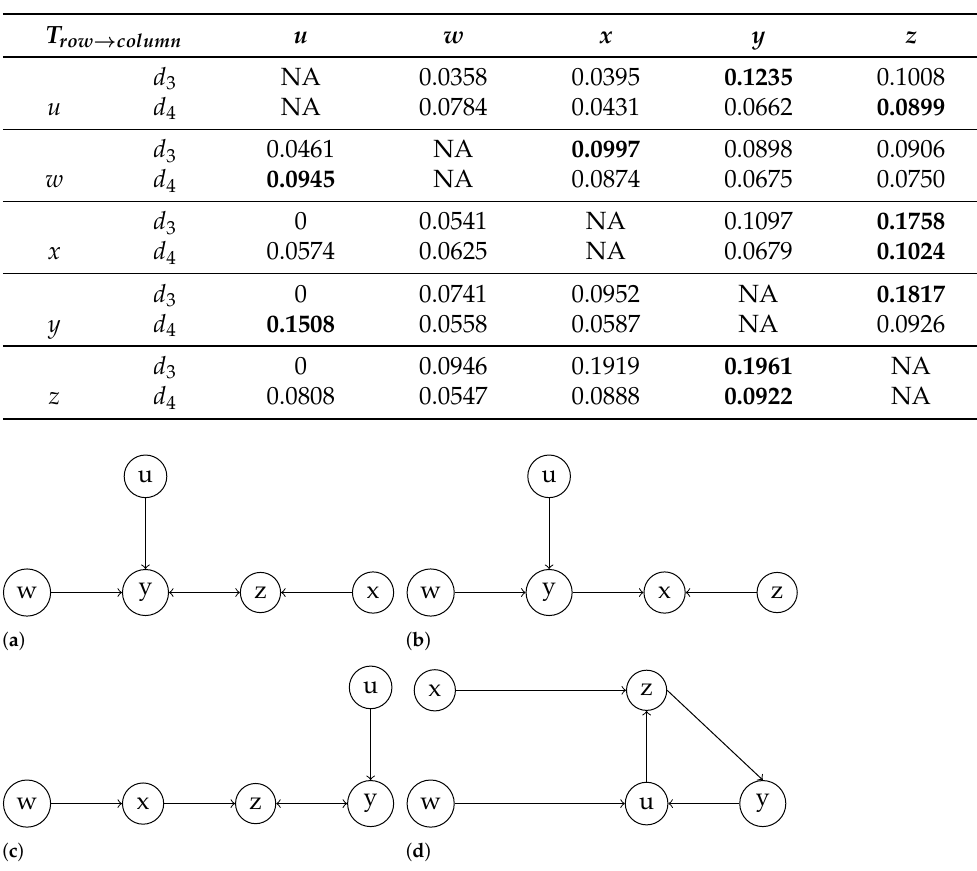
Table 9. Transfer Entropy coefficient for 2nd variant ( n divisor equals 100).